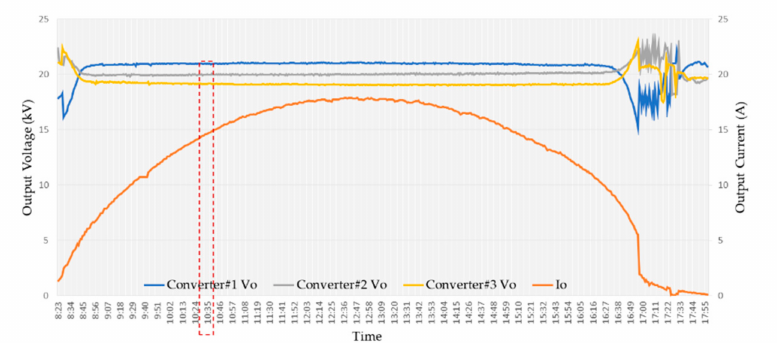
Figure 25. Converters waveform in stable irradiance